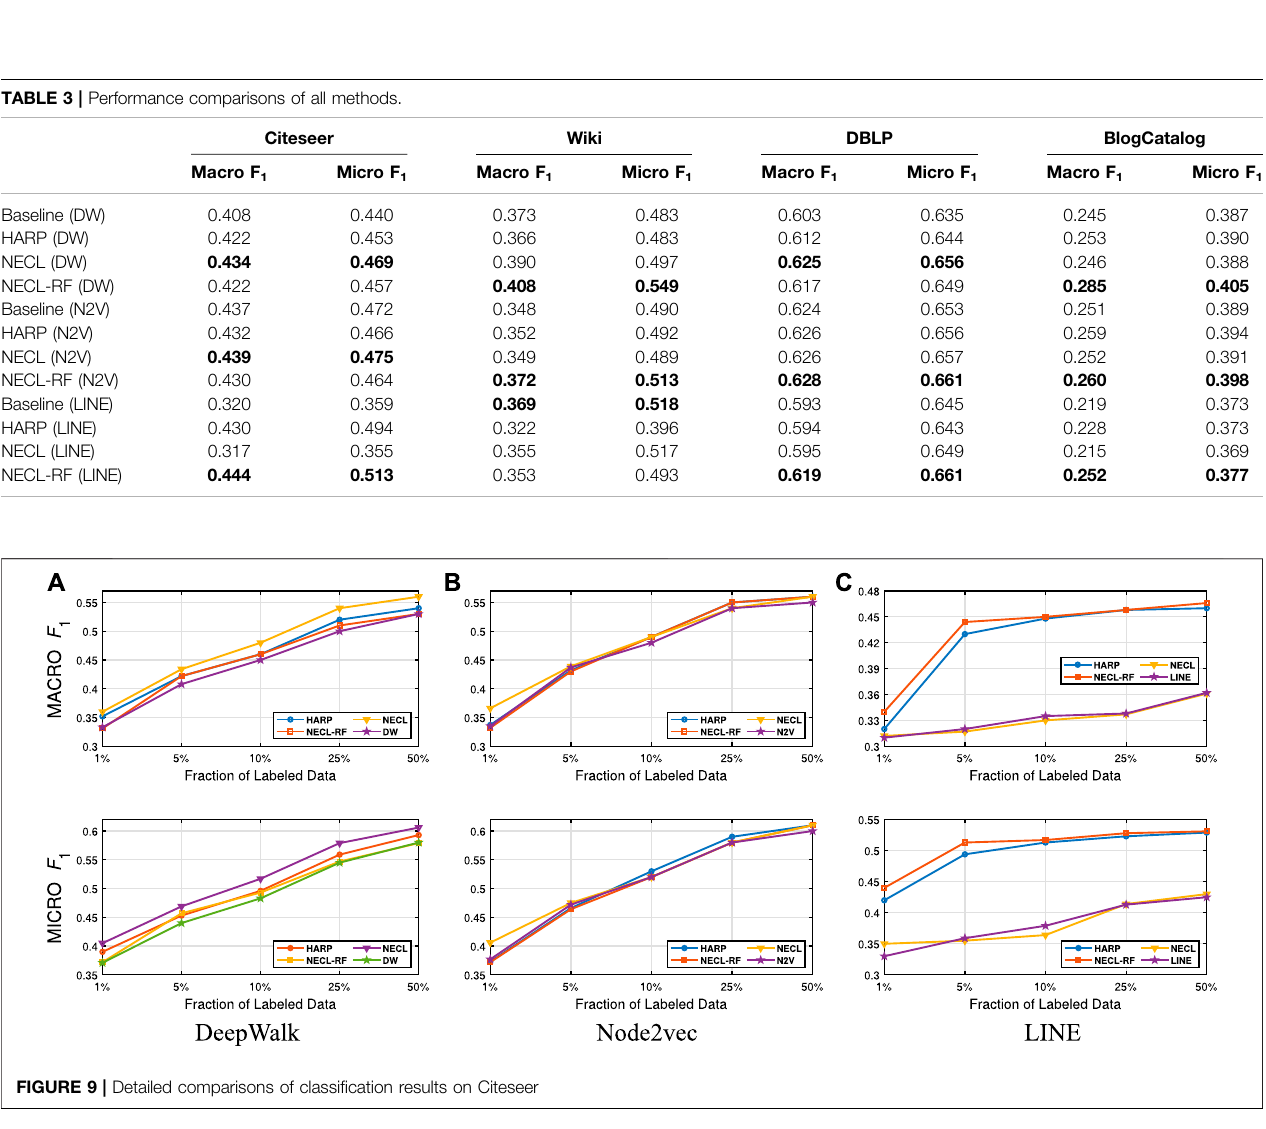
FIGURE 8 | The ratio of vertices/edges of the compressed graphs to that of the original graphs. (Citeseer (A) , Wiki (B) , DBLP (C) and BlogCatalog (D) ).